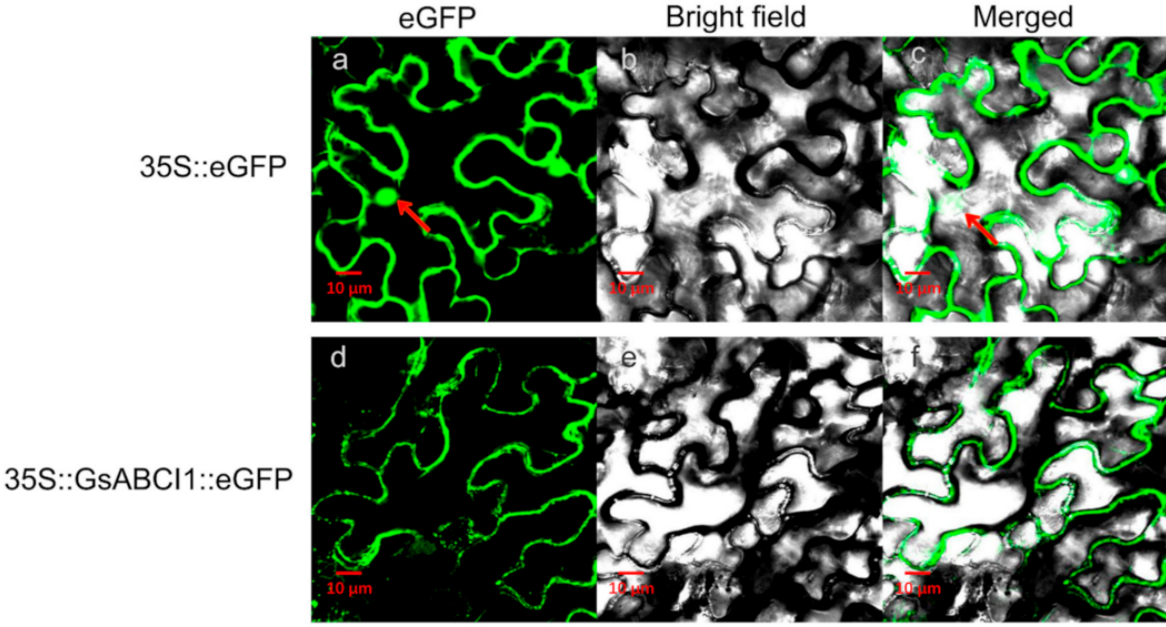
Figure 7. Subcellular localization of GsABCI1 in Nicotiana benthamiana cells. ( a – c ) Localization of 35S::eGFP in N. benthamiana leaf cells. ( d – f ) Localization of 35S:GsABCI1::eGFP in N. benthamiana leaf cells. Fluorescence signs in the epidermal cells were analyzed by confocal microscopy. The specific vector was transformed into N. benthamiana leaf by an infiltration method. ( a , c ) The arrows indicate the position of the